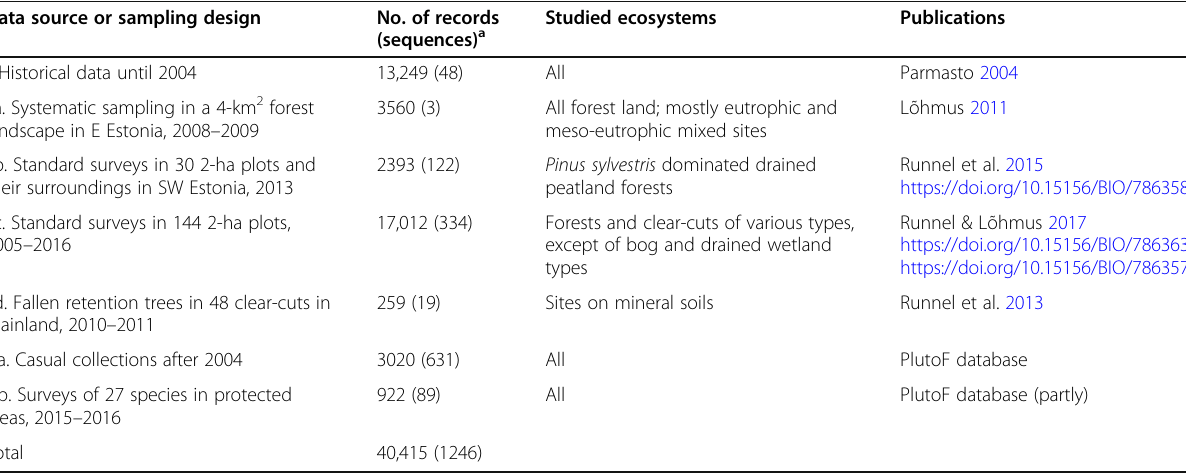
Table 1 Main sources of the Estonian polypore data Data source or sampling